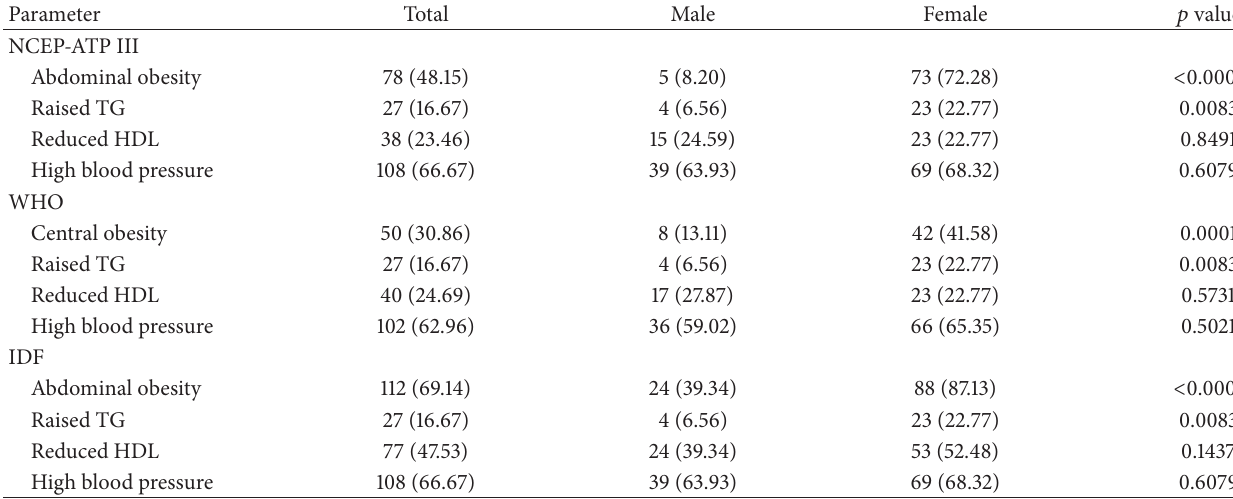
Table 5: Prevalence of the various components of metabolic syndrome among the study population stratified by